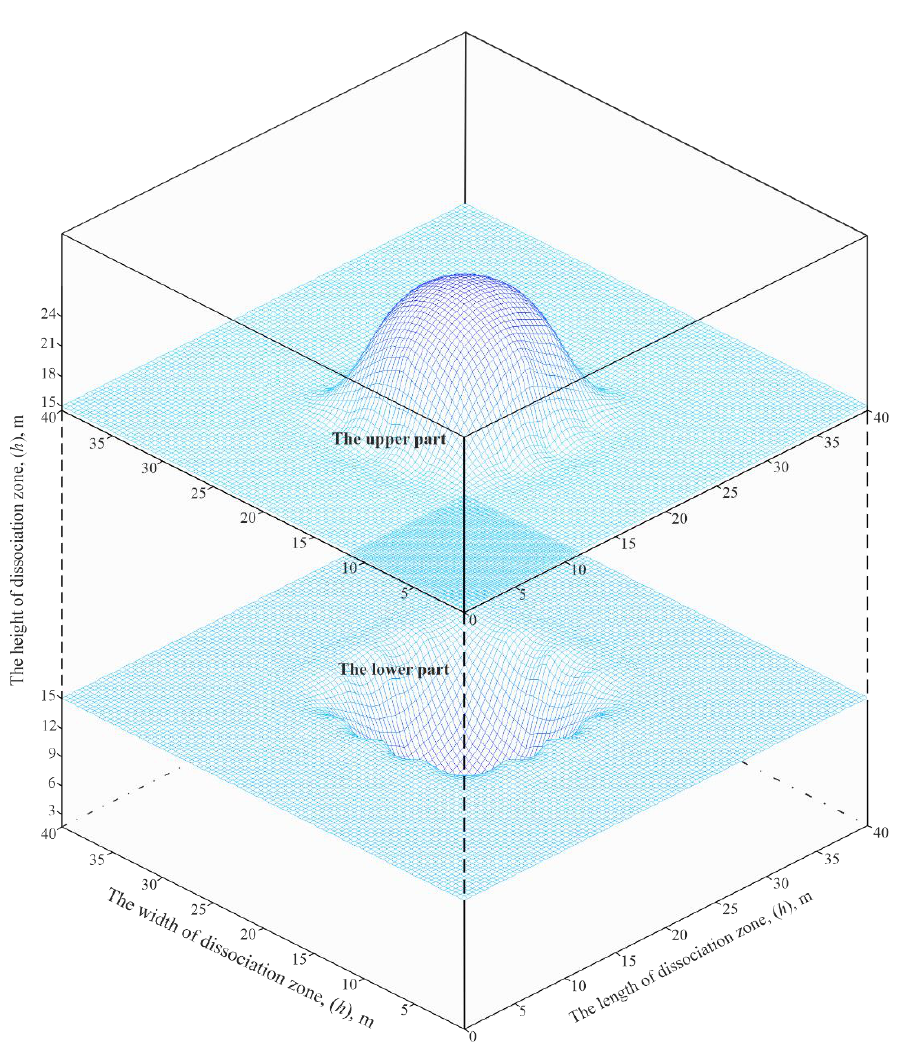
Figure 9. 3D grid-visualization of the upper and lower parts of the gas hydrate deposit (the share of rock intercalation = 30%).